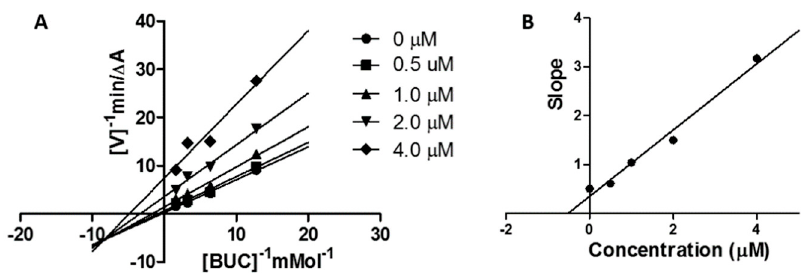
Figure 3. Kinetic study of 23 on BChE inhibition. ( A ) The Lineweaver–Burk reciprocal plots records enzyme velocity curves-substrate concentration in the presence of 23 at different concentrations; ( B ) Plot of slopes versus the concentrations of 23 .